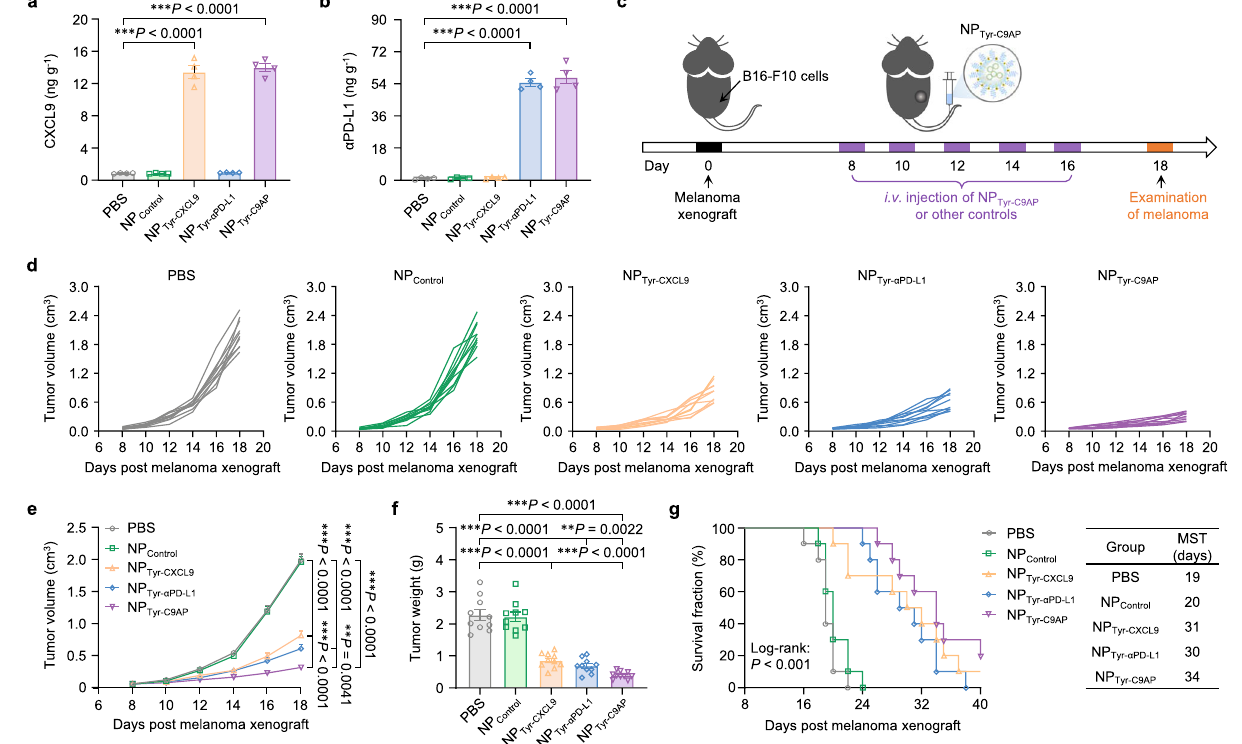
Fig. 6b, c, the tumor growth inhibition rate of NP Tyr- α PD-L1 group (64.2%) was higher than that of anti-PD-L1 group (58.0%), and the fi nal tumor weights of NP Tyr- α PD-L1 group were lower than that of anti-PD-L1 group, indicating that speci fi cally expressing α PD-L1 in the tumor